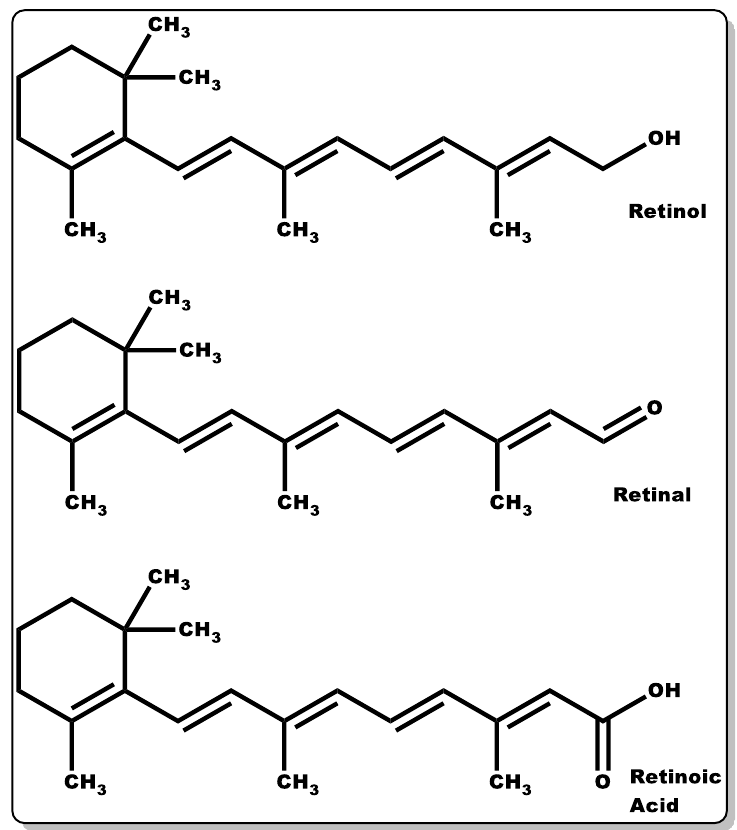
Figure 6. Molecular structures of retinol, retinaldehyde, and retinoic acid.